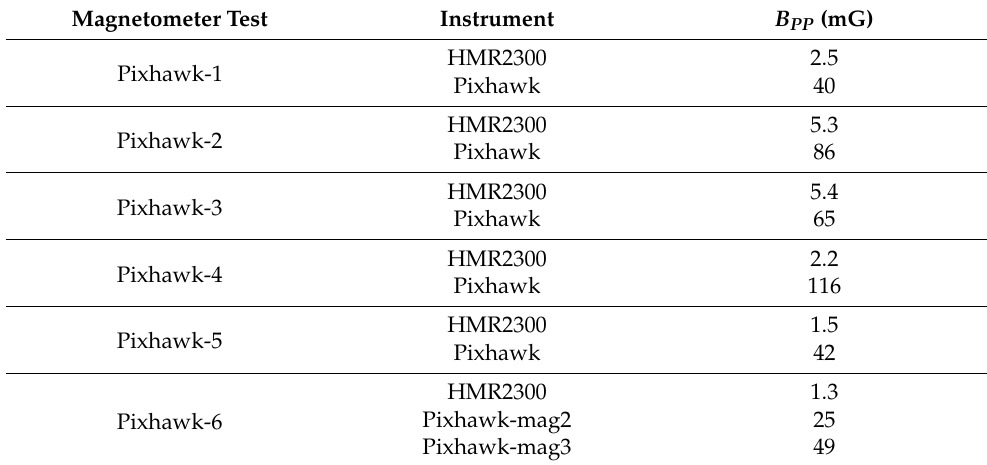
Table 3. Maximum peak-to-peak amplitude of magnetic field B PP considering the three axes. Magnetometer